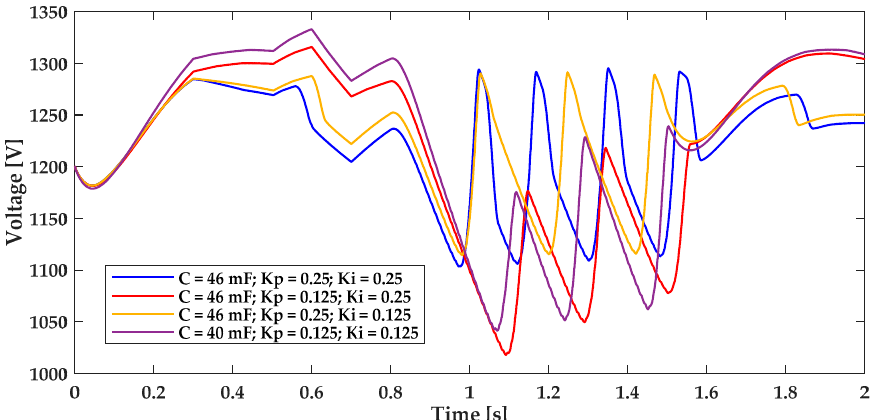
Figure 16. Stability of DC voltage for different values of the PI parameters.